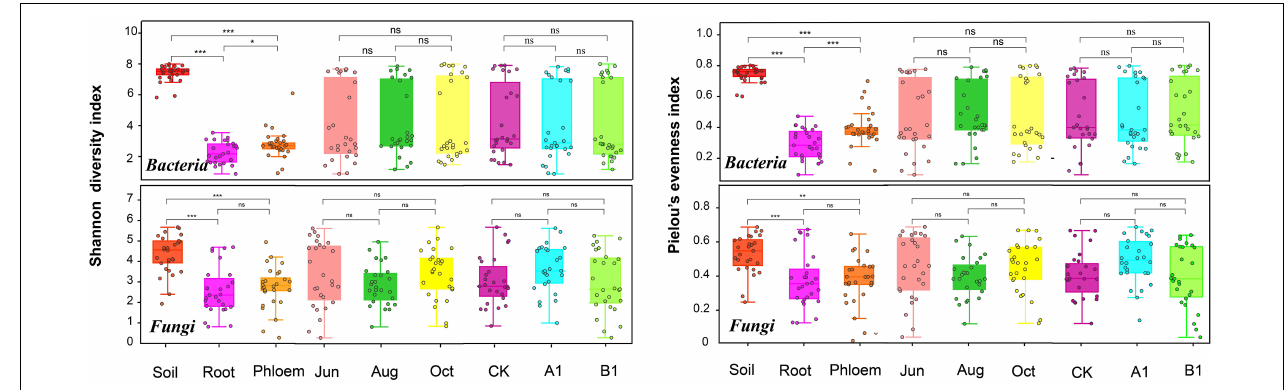
FIGURE 1 | Shannon’s diversity and Pielou’s evenness of both the bacterial and fungal communities across the three habitat classifications (soil, roots, and stems), seasons (June, August, and October) and genotypes (CK, A1, and B1). For both bacteria and fungi, diversity differed significantly across habitats. * P < 0.05 between groups. ** P < 0.01 between groups. *** P < 0.001 between groups. ns: There were no significant differences between